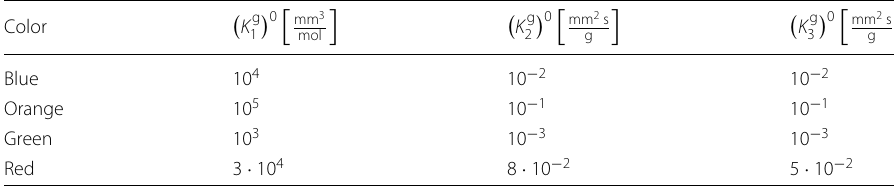
Table6 Initial guesses for different inverse analysis runs in growth